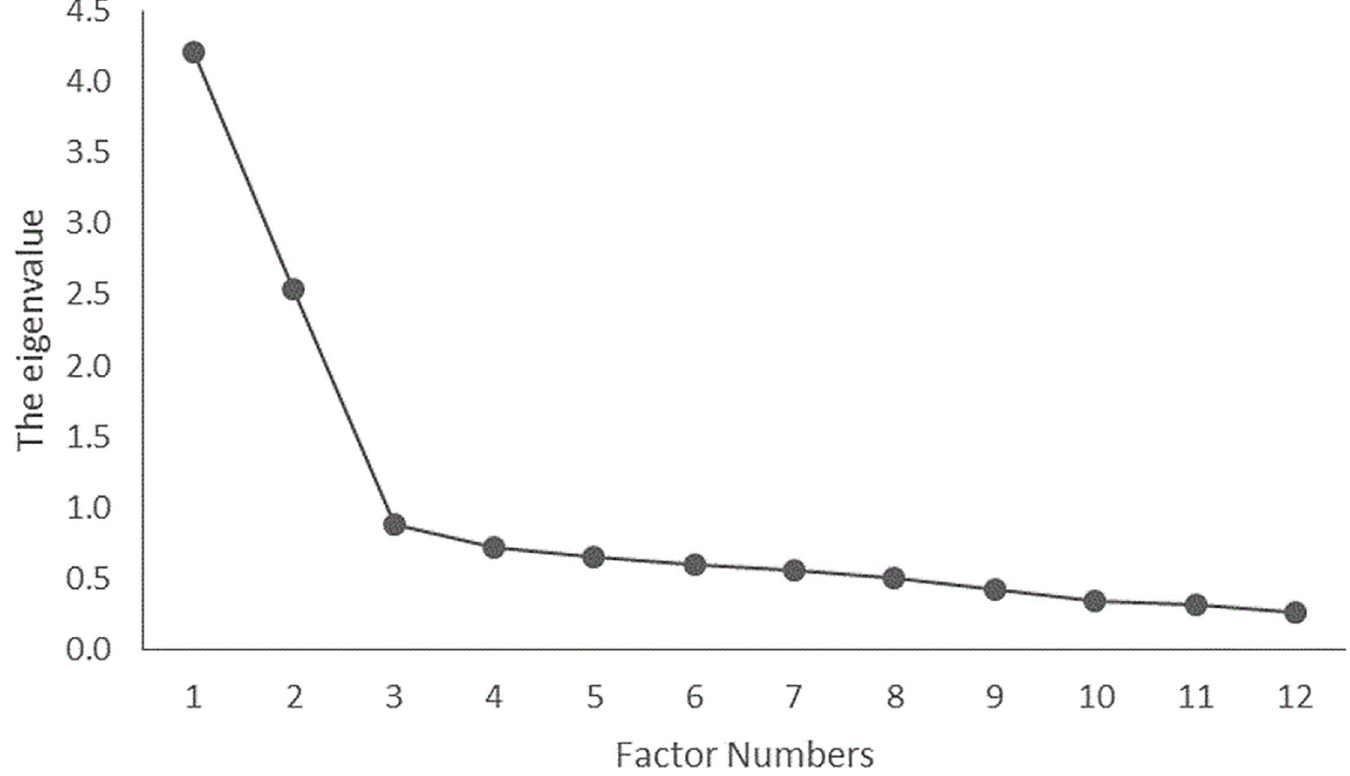
Fig 2. Factor decay rate related to decreased self-efficacy among psychiatric nurses.